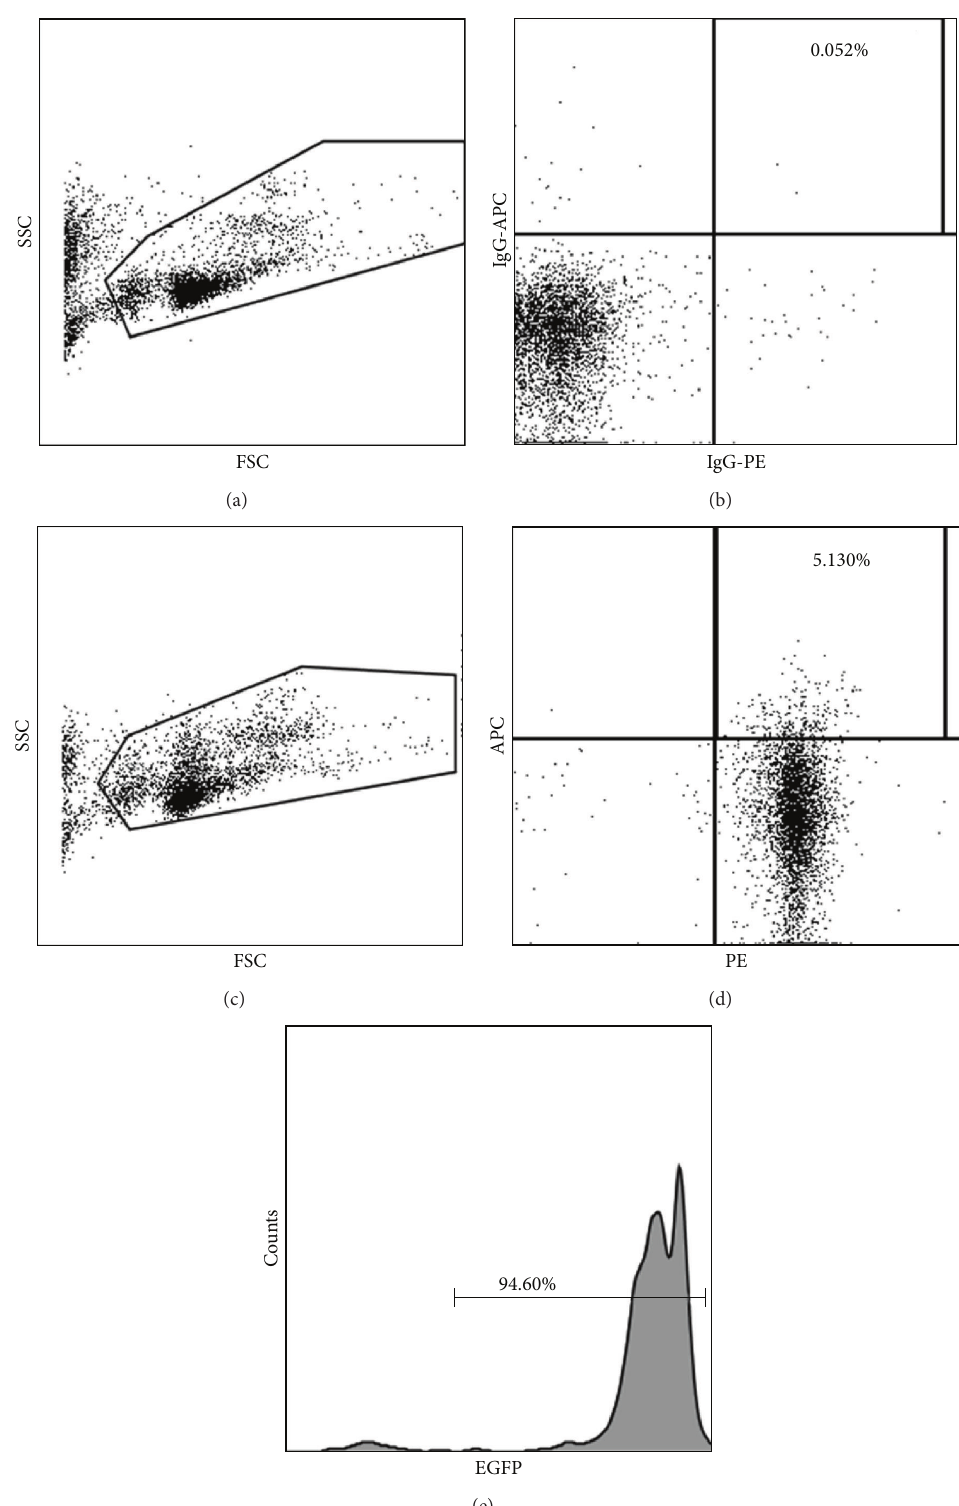
Figure 3: HSC-derived circulating fibroblast precursors are present in the peripheral blood of engrafted mice. Peripheral blood of engrafted nonadherent bone marrow transplanted mice was analyzed for the presence of CFPs. Representative forward scatter and side scatter gate is shown Panel (a) and isotype control is shown in Panel (b). Panels (c)–(e) depict analysis of peripheral blood from a representative animal. Forward and side scatter gate is shown in Panel (c). The population expressing CD45 (PE) and DDR2 (APC) is shown in Panel (d) (upper right quadrant). Analysis of EGFP expression of gated CD45 + /DDR2 + population from Panel (d) is shown in Panel (e)